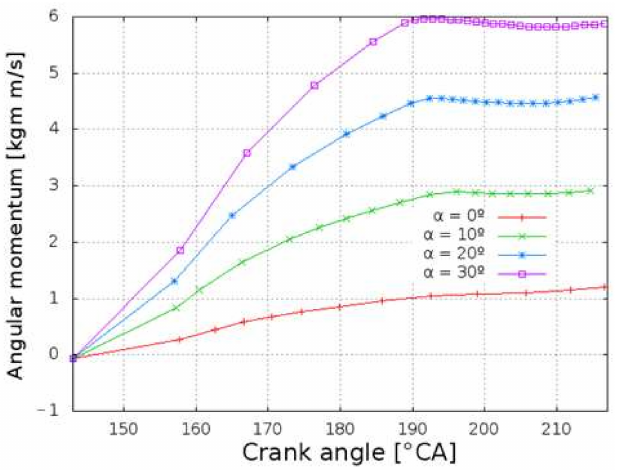
Figure 18. The variation of angular momentum over time for different scavenging port angles. The influence of the scavenging port angle on the scavenging performance is sum- marized in Table 8. With a greater angle, the delivered mass of air through the ports decreases slightly because of the rising of the flow resistance. This adds to the smaller axial momentum and results in a decrease in scavenging efficiency for bigger angles. The charging efficiency decreases from 0.9203 to 0.7842 and the delivery ratio decreases from 1.4452 to 1.2176. The trapping efficiency, on the other hand, increases by a small amount with the increase in the port angle. The results indicate that the industry standard of 20 ◦ scavenging port inclination could be decreased as far as scavenging efficiency is concerned. The result is also supported to some extent by other papers [9]. However, the swirling motion is important also for air–fuel mixing and cylinder liner